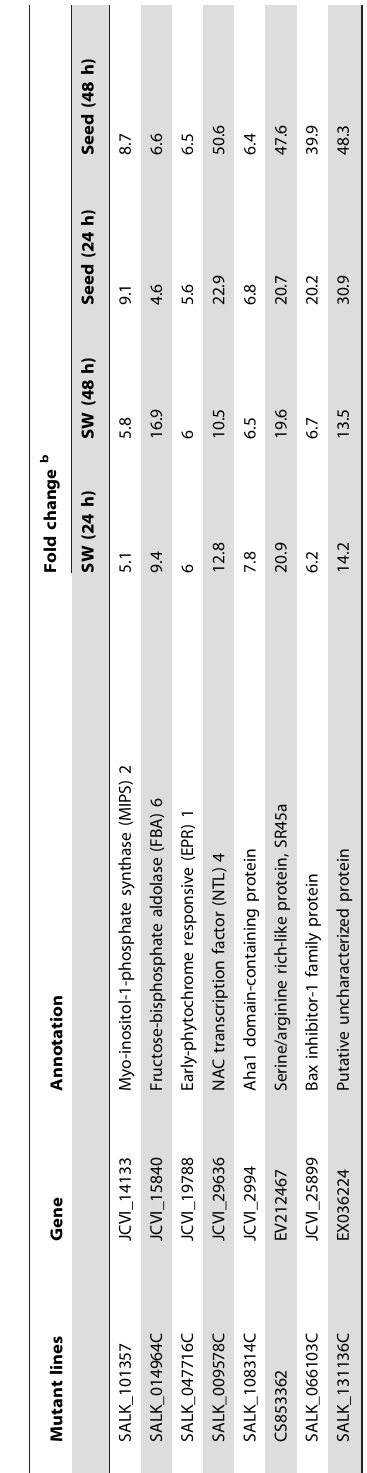
(Table 3). Eight Arabidopsis T-DNA insertion mutant lines based on the candidate genes of B. napus were obtained from the Arabidopsis Biological Resource Center (ABRC). The homozy- gous lines of these mutants were isolated and confirmed by PCR analysis. RT-PCR showed that the expression of the selected gene in each mutant was completely abrogated (Figure S3). Some of these genes are known to participate in abiotic stress, such as EPR1 in light rhythm [37], NTL4 in ROS regulation during drought- E V induced senescence [87] and SR45a in alternative splicing under high light [88]. To characterize the thermotolerance of the mutant plant lines, their seeds were treated at 45 u C for 5 h. The germination rates of all the mutant lines were not significantly different from WT plants, but the positive control hsp101 decreased to 6.1% of WT (Figure 8A). Because no significant difference in basal thermo- tolerance with seed was observed, severe heat stress (45 u C for 30 min) was applied to 7-d-old seedlings grown under normal condition directly, or acclimated from a moderate heat stress treatment (38 u C for 90 min) which was followed by either a short (2 h) or long recovery (2 d). Two mutant lines, h23 and h38 , exhibited reduced survival rates (59.3% and 56.9% of WT, respectively) (Figures 8B-8D), suggesting that the genes were involved in thermotolerance during the vegetative growth stage.